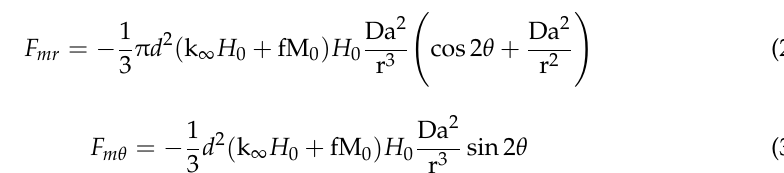
Figure 4. ( a ) Schematic diagram of major forces on a magnetic particle in a fluid. ( b ) Magnetization curve of Gd 2 O 3 and La 2 O 3.